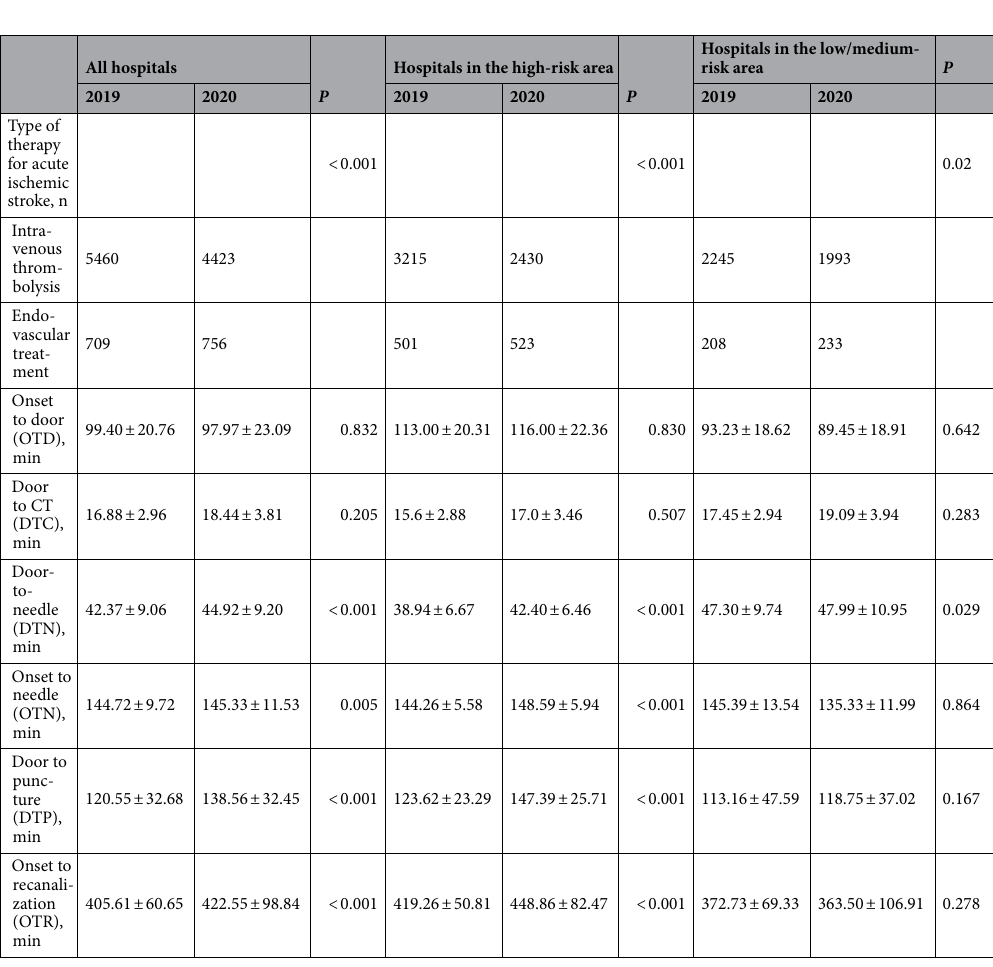
Table 2. Quality measures of the acute care provided for ischemic stroke between 2020 and 2019.